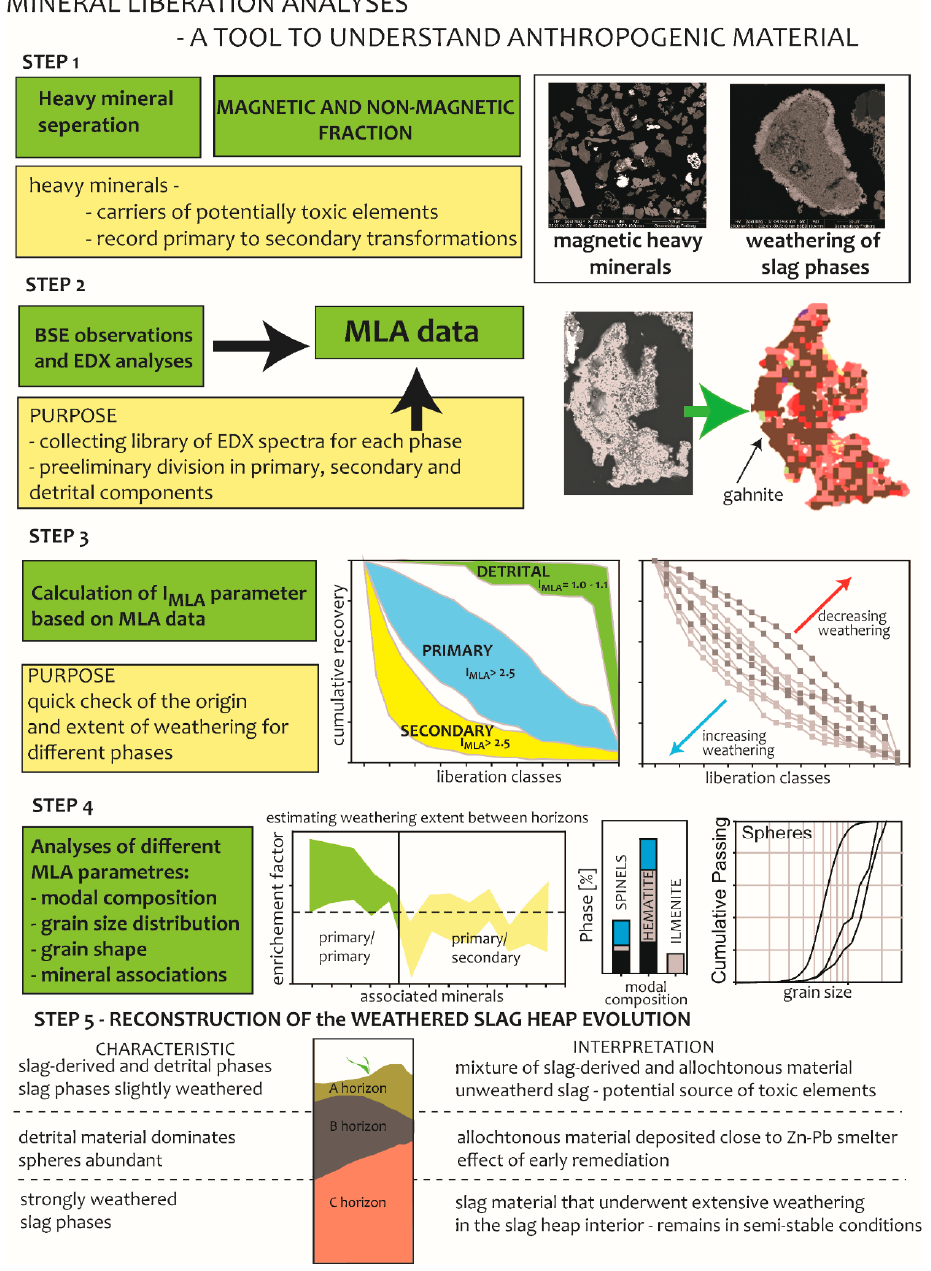
Figure 9. A schematic approach to the analysis of heavy mineral assemblages in a complex Technosol site, Steps 1 to 3 provide a quick check of possible sources of phases in soil and/or soil substrate, steps 1–5 provide a detailed scenario of soil substrate evolution and predictions.